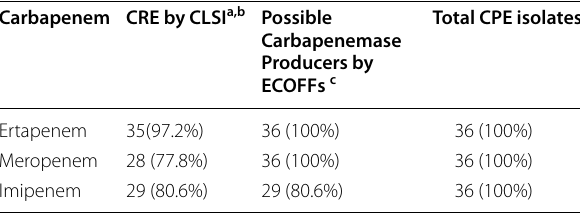
* Urology Department showed highest percent for CRE positive isolates with a statistical significance (P value